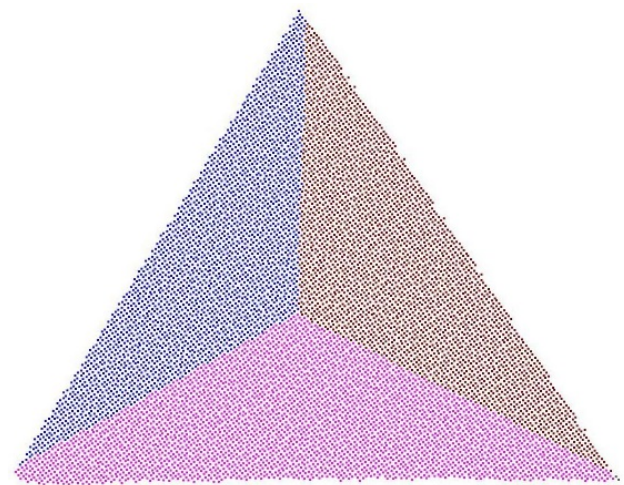
Figure 9. The point cloud of triangular pyramid.